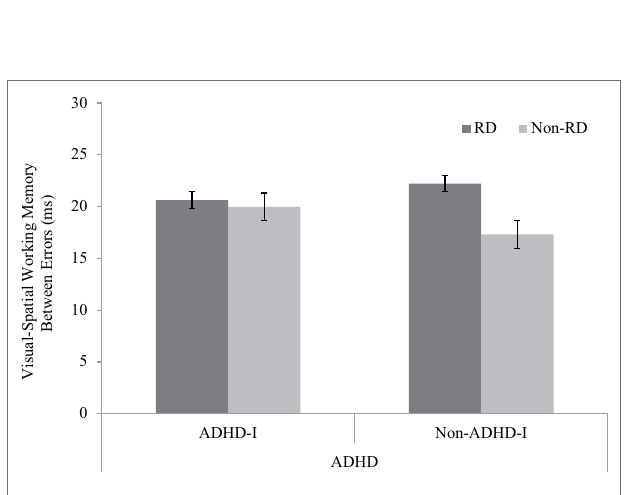
FIGURE 3 | Interaction effect of ADHD-I and RD in visual-spatial working